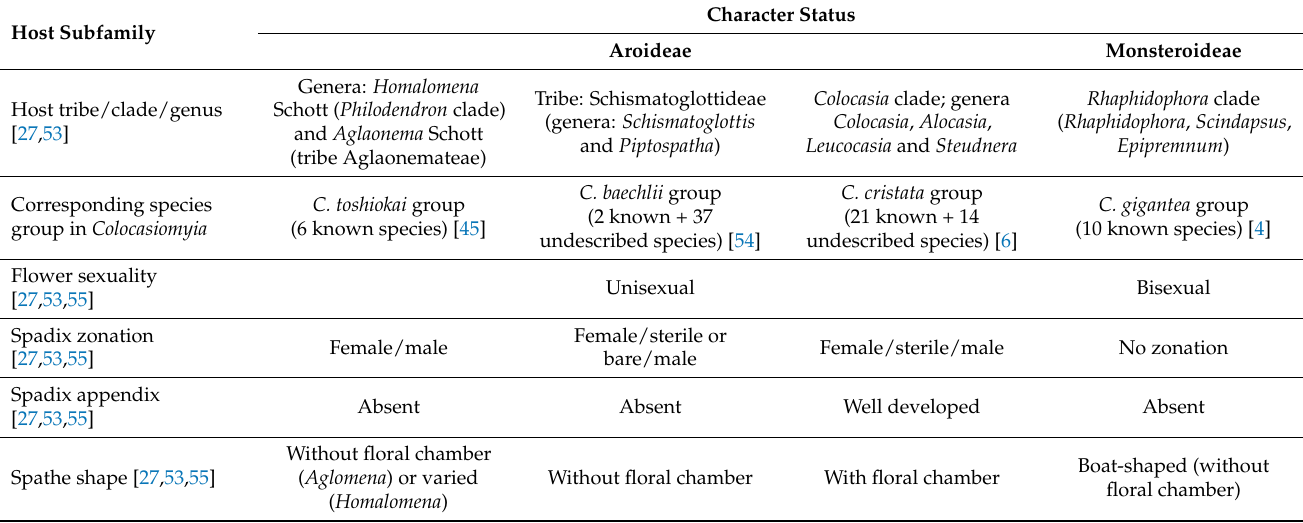
Table A1. Comparison between host taxa of four aroid-breeding species groups in Colocasiomyia